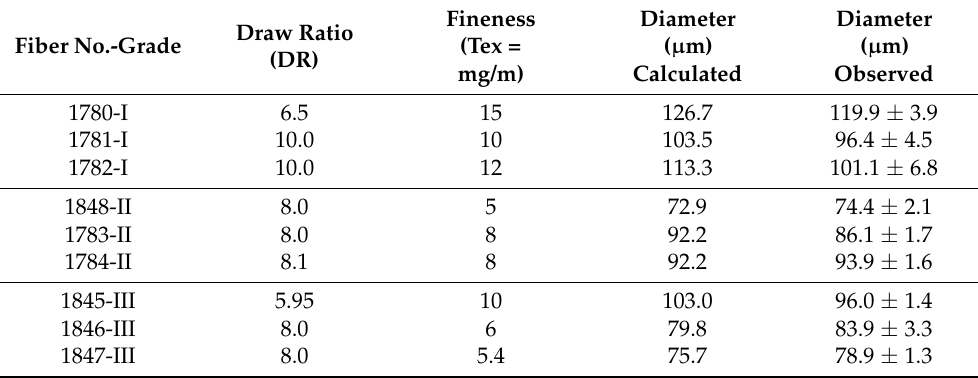
Table 4. Draw ratio, fineness and determined diameters.